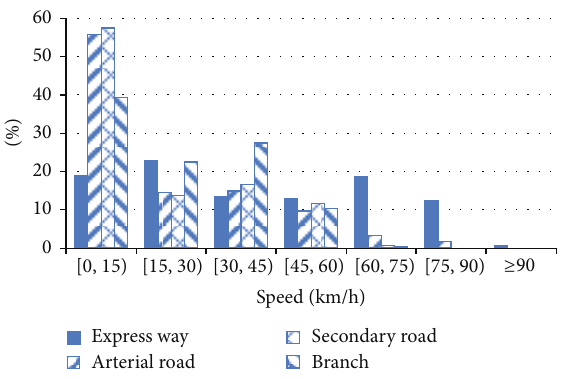
Figure 3: The speed distribution for different road